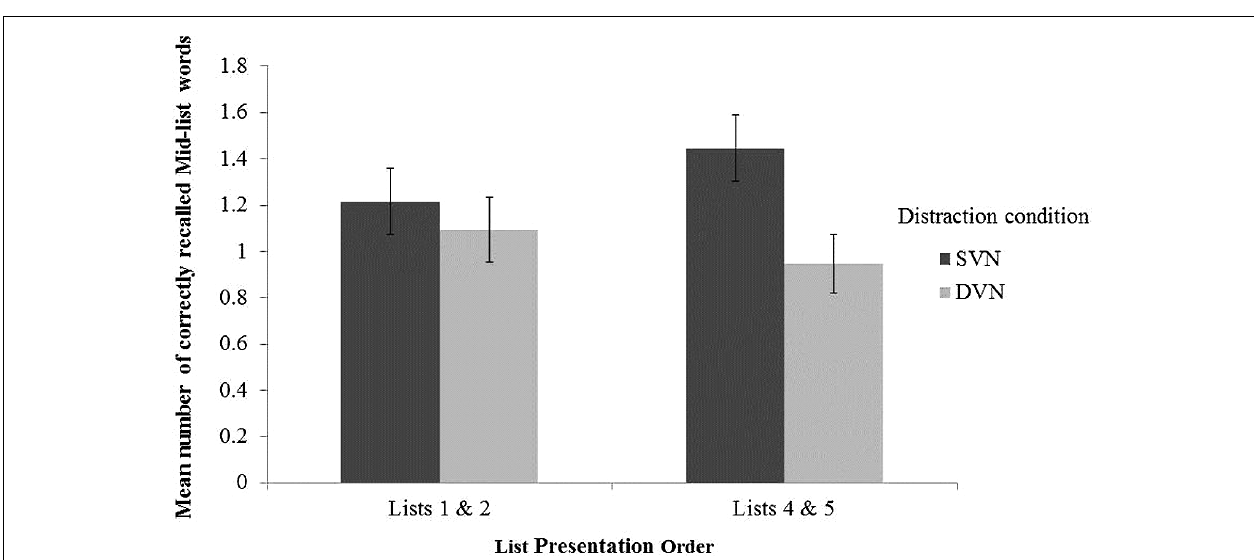
FIGURE 3 |The mean number of correctly recalled mid-list words from the first two- and last two- presented lists. Error bars represent standard errors of the mean.